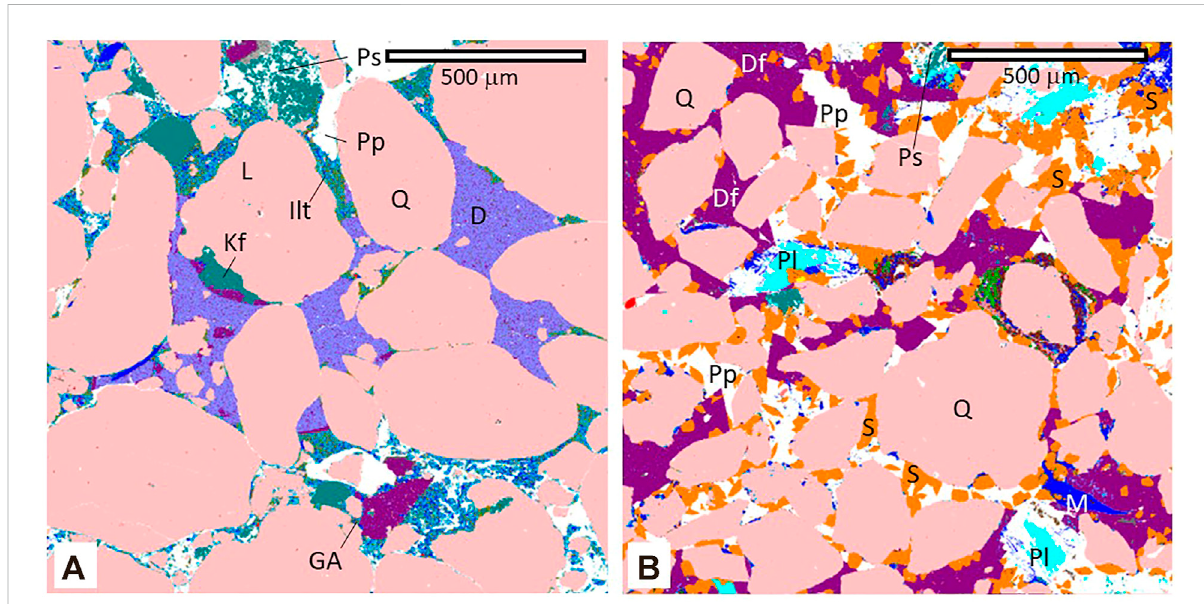
FIGURE 11 Dolomite and otherpore- fi llingcements insandstones(mineralcolour index inFigure 3). (A) Detritalquartz (Q)-dominated Triassic continental red-bedsandstonefromtheIrishSeaBasin,UnitedKingdom,withminorK-feldspar(Kf),localisedpore fi llinganhydrite(GA),laterpore- fi llingillite(Ilt) with dolomite (D) cement being the latest mineral to develop. There is little primary porosity (Pp) remaining due to extensive cementation but some secondary porosity (Ps) is present within altered K-feldspar grains. (B) Detrital quartz-dominated Mid Jurassic deltaic sandstones from Halten Terrace, Norway, with minor plagioclase, from a sample at > 4,000 m and approximately 110 ° C. Extensive grain-coating siderite (S) is present that may have inhibited later quartz cement. Siderite was followed by the growth of pore- fi lling ferroan dolomite (Df). There are localised patches of remaining primary porosity. There may be localised development of quartz cement in this sample, but it cannot be discerned using